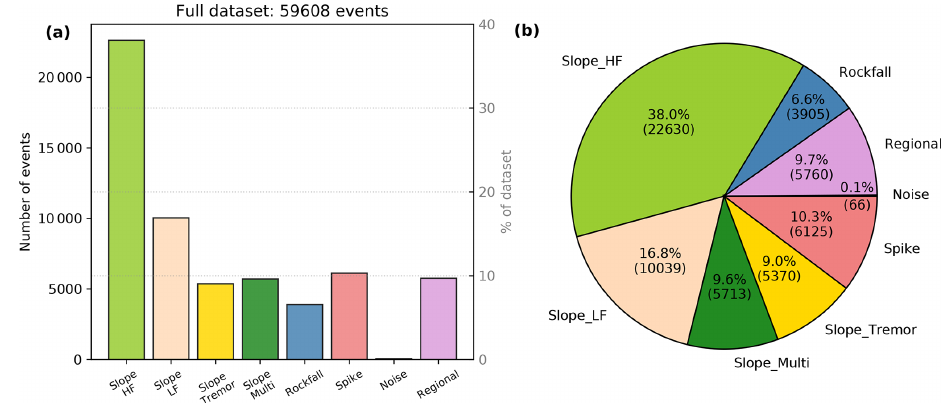
Earth Surf. Dynam., 11, 89–115,